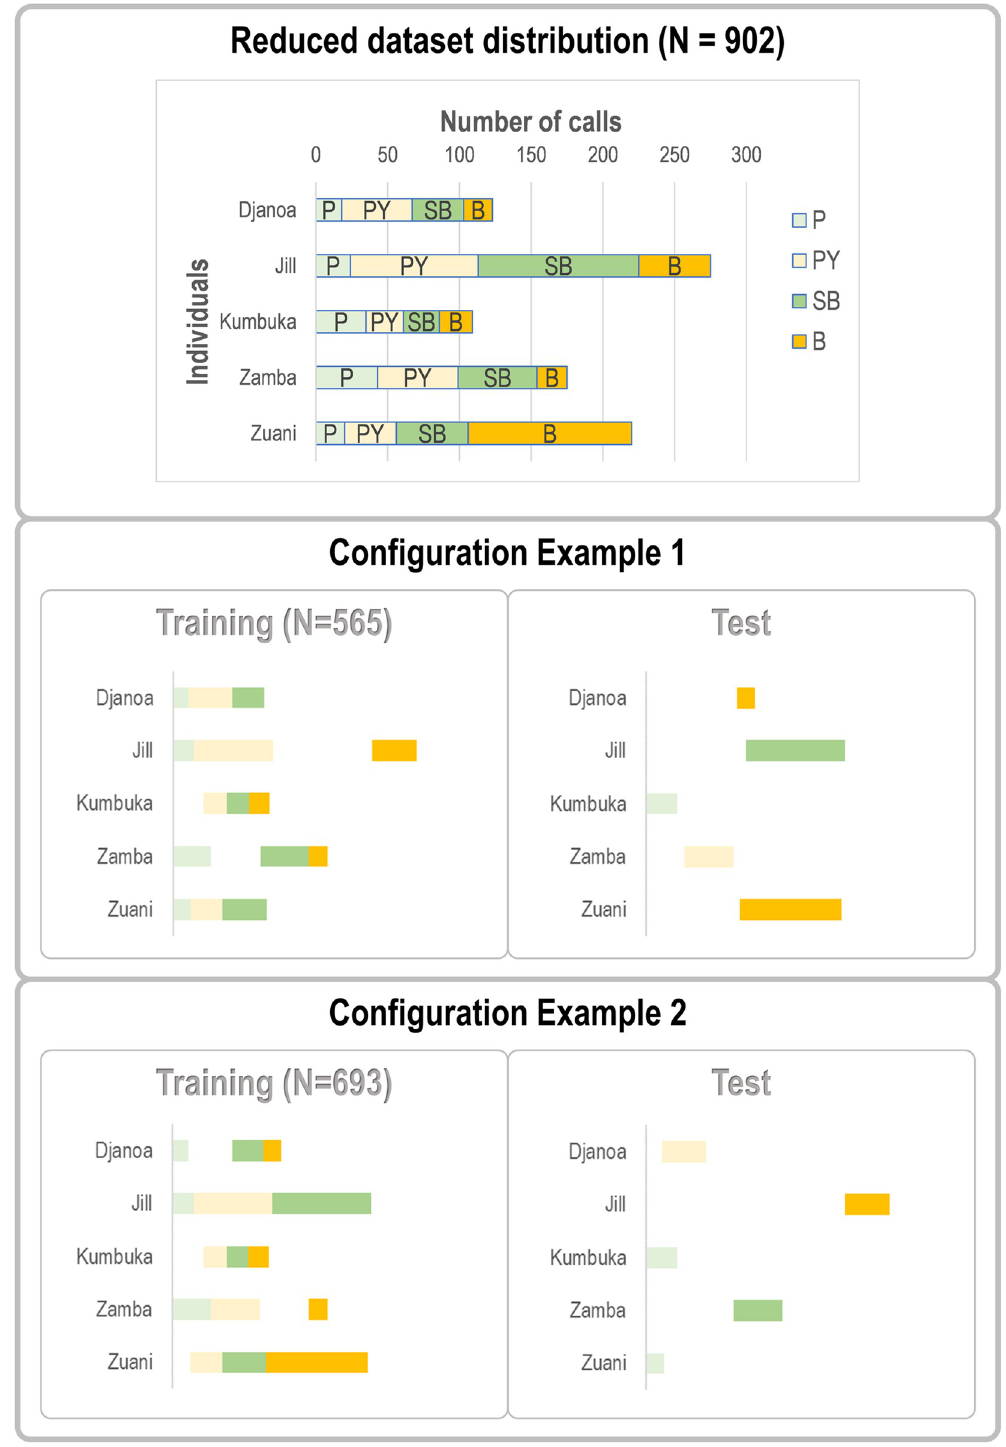
Fig 14. Illustration of a strategy to minimize information leakage when building training and test sets for a classification / discrimination task. The upper panel shows the distribution of call types per individual in our reduced dataset. The middle and lower panels display two configurations for the training and test sets where each call type for a given individual appears only in one of the two sets.